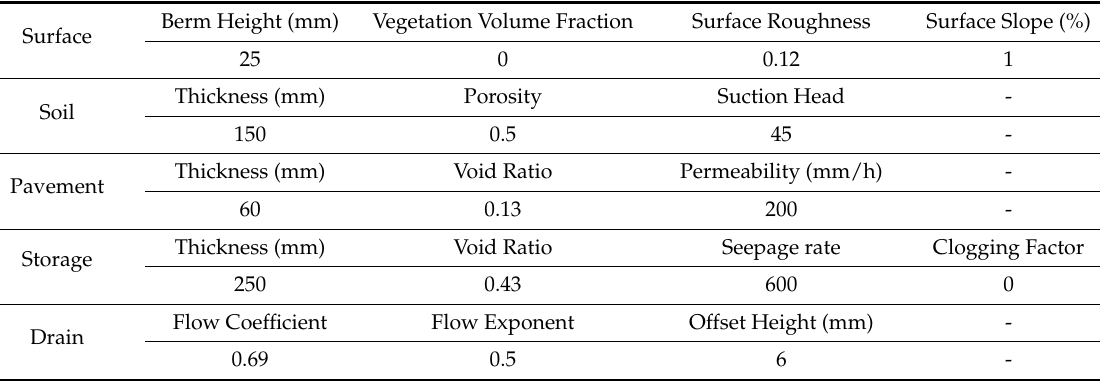
Table 2. Parameters of permeable pavement in SWMM.